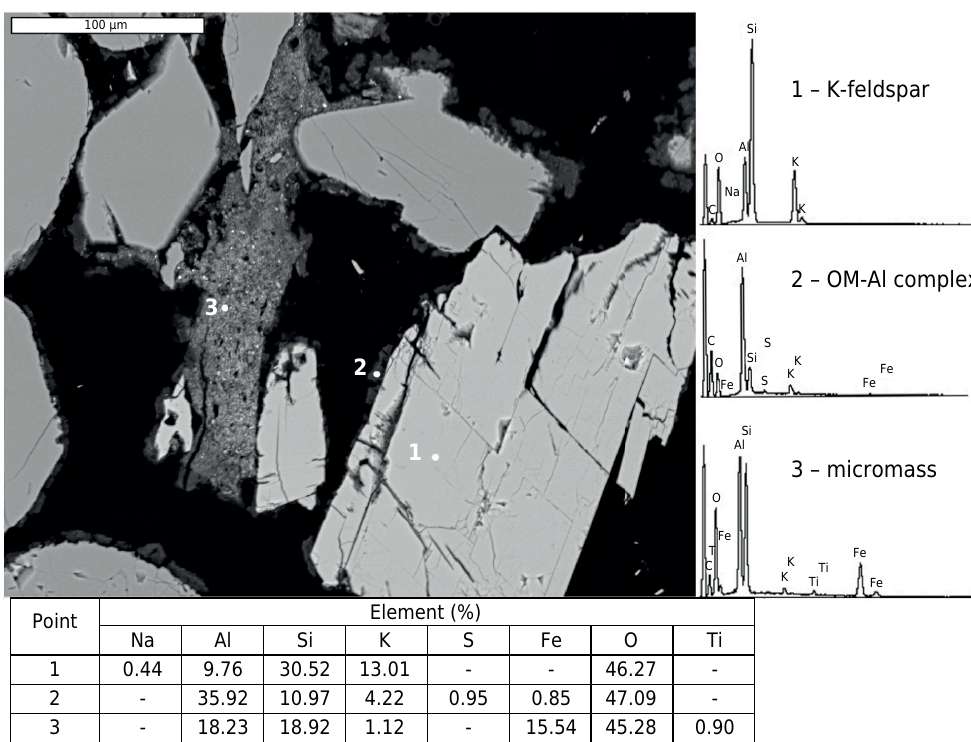
Figure 4. Detailed photomicrographic of C2 horizon of P2 with qualitative and quantitative EDS analyses: (1) K-feldspar crystal; (2) OM-Al complexes with illuvial feature; and (3)